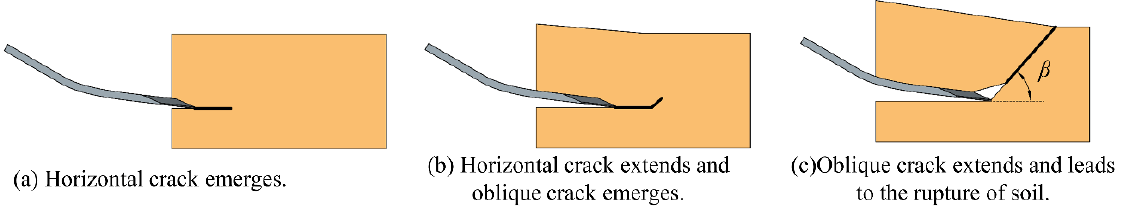
Figure 14. Soil failure evolution under the influence of PDS.